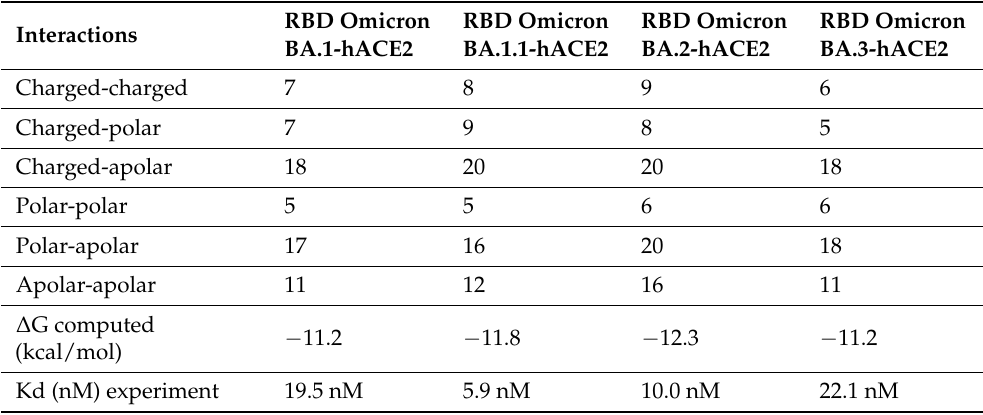
Table 4. The analysis of the interfacial residue-residue contacts and ensemble-averaged PRODIGY- based binding free energies for the Omicron RBD-hACE2 complexes